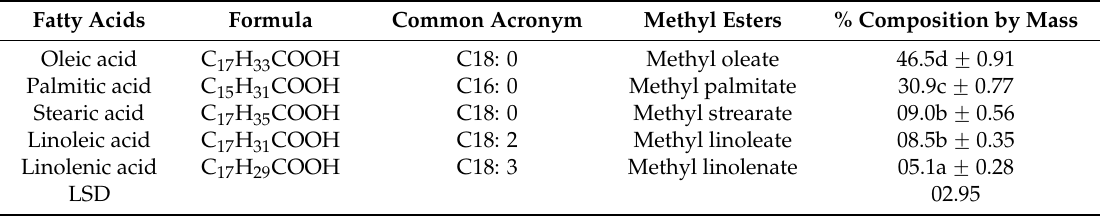
Table 2. Fatty acid profile of WCO and its biodiesel fatty acid methyl